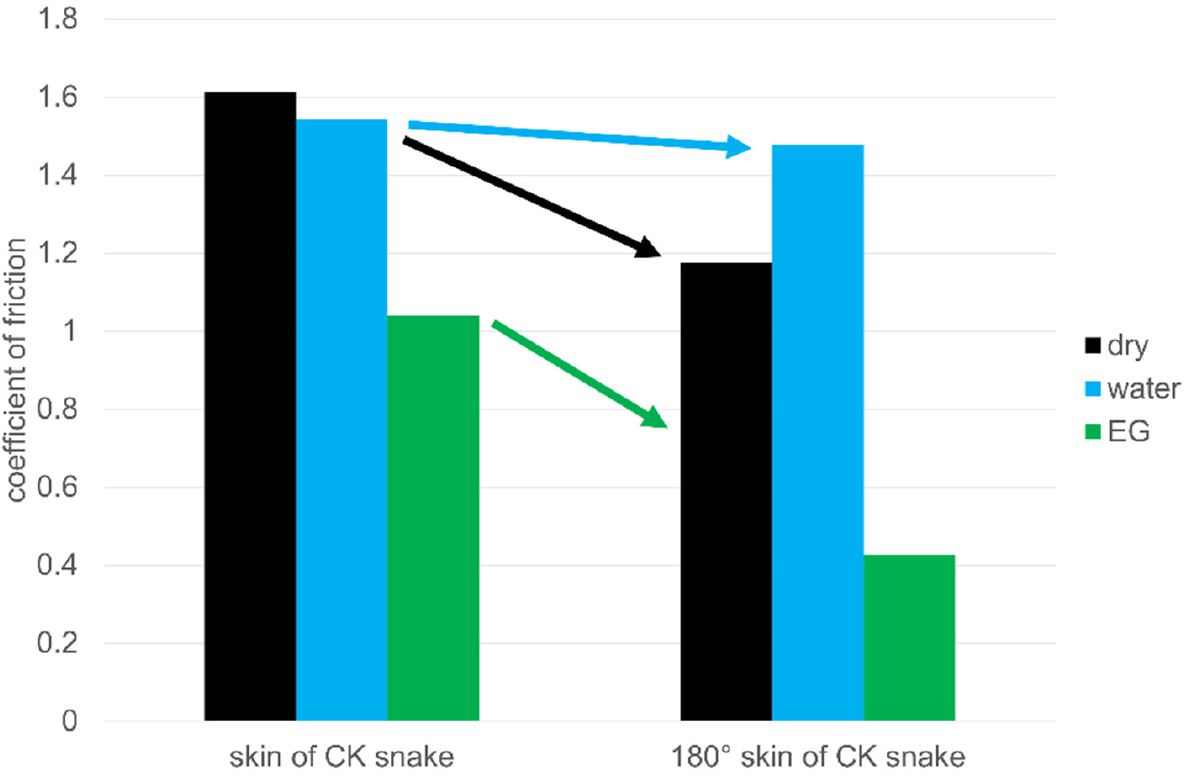
Figure 14. Anisotropic friction values in the examination of real snakeskin molded in LSR as a bioinspired reference structure.